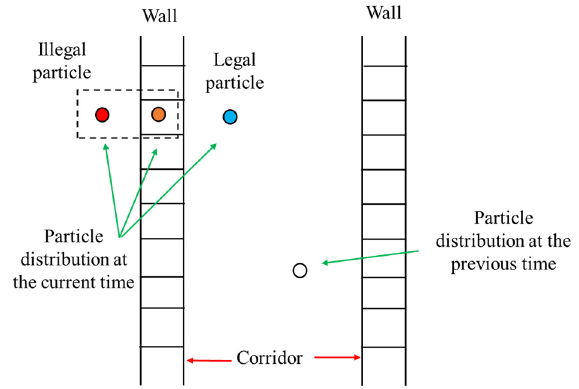
Figure 3. Schematic diagram of the update of the particle position.